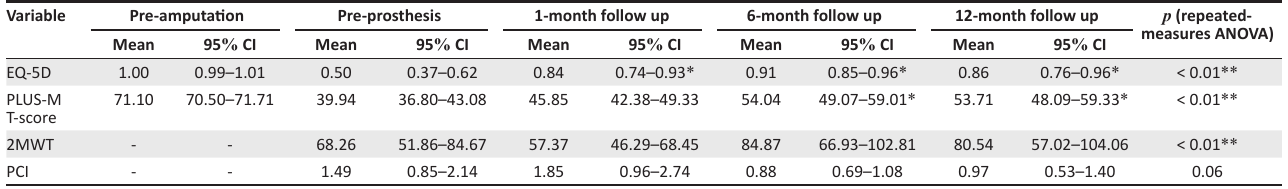
TABLE 1-A1: Patient-reported outcomes of health-related quality of life and mobility before amputation (pre-amputation), at the casting visit before prosthesis fitting (pre-prosthesis) and at 1 month (1 mo), 6 months (6 mo) and 12 months (12 mo) follow-up after prosthesis fitting.